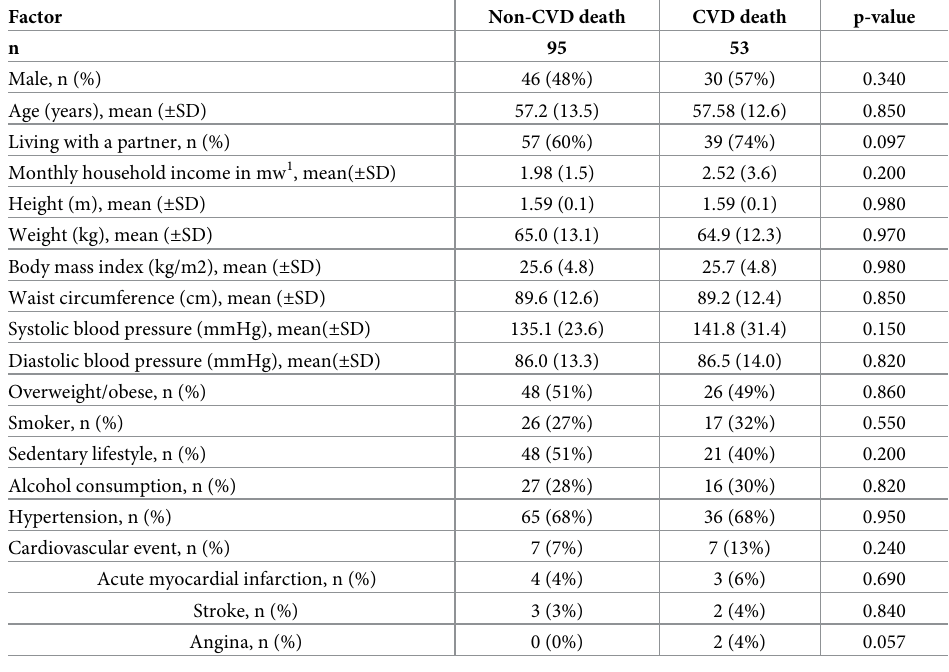
Table 2. Baseline cohort characteristics according to cause of death in 2015 (n = 148).